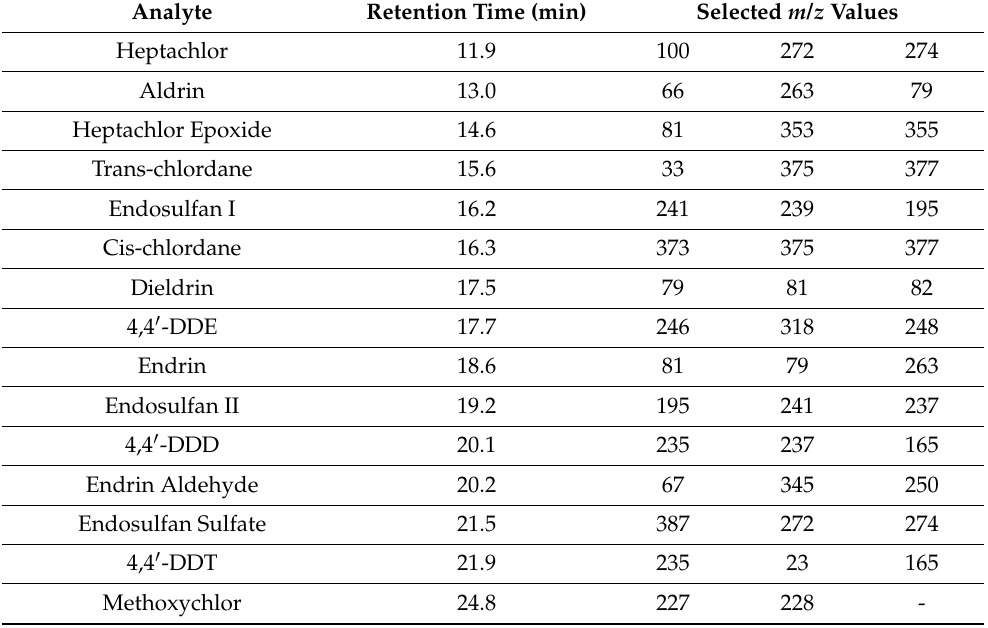
Table 2. OCPs, retention times, and selected m / z values for selective ion monitoring (SIM)